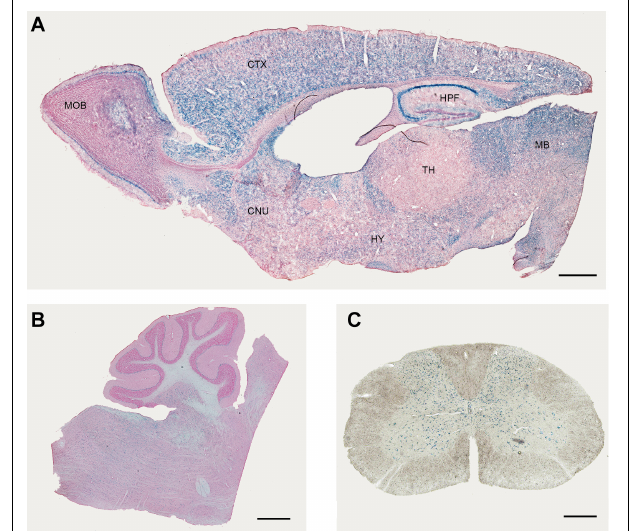
FIGURE 1 | Expression of Elovl5 in the central nervous system. XGal staining (blue) indicates an ubiquitary expression of Elovl5 gene in forebrain (A) , cerebellum and brainstem (B), spinal cord (C) . MOB, Main Olfactory Bulb; CTX, Cortex; HPF, Hippocampus; MB, midbrain; TH, thalamus; HY, Hypothalamus; CNU, cerebral nuclei. Scalebars: (A,B) 500 µ m and (C) 50 µ